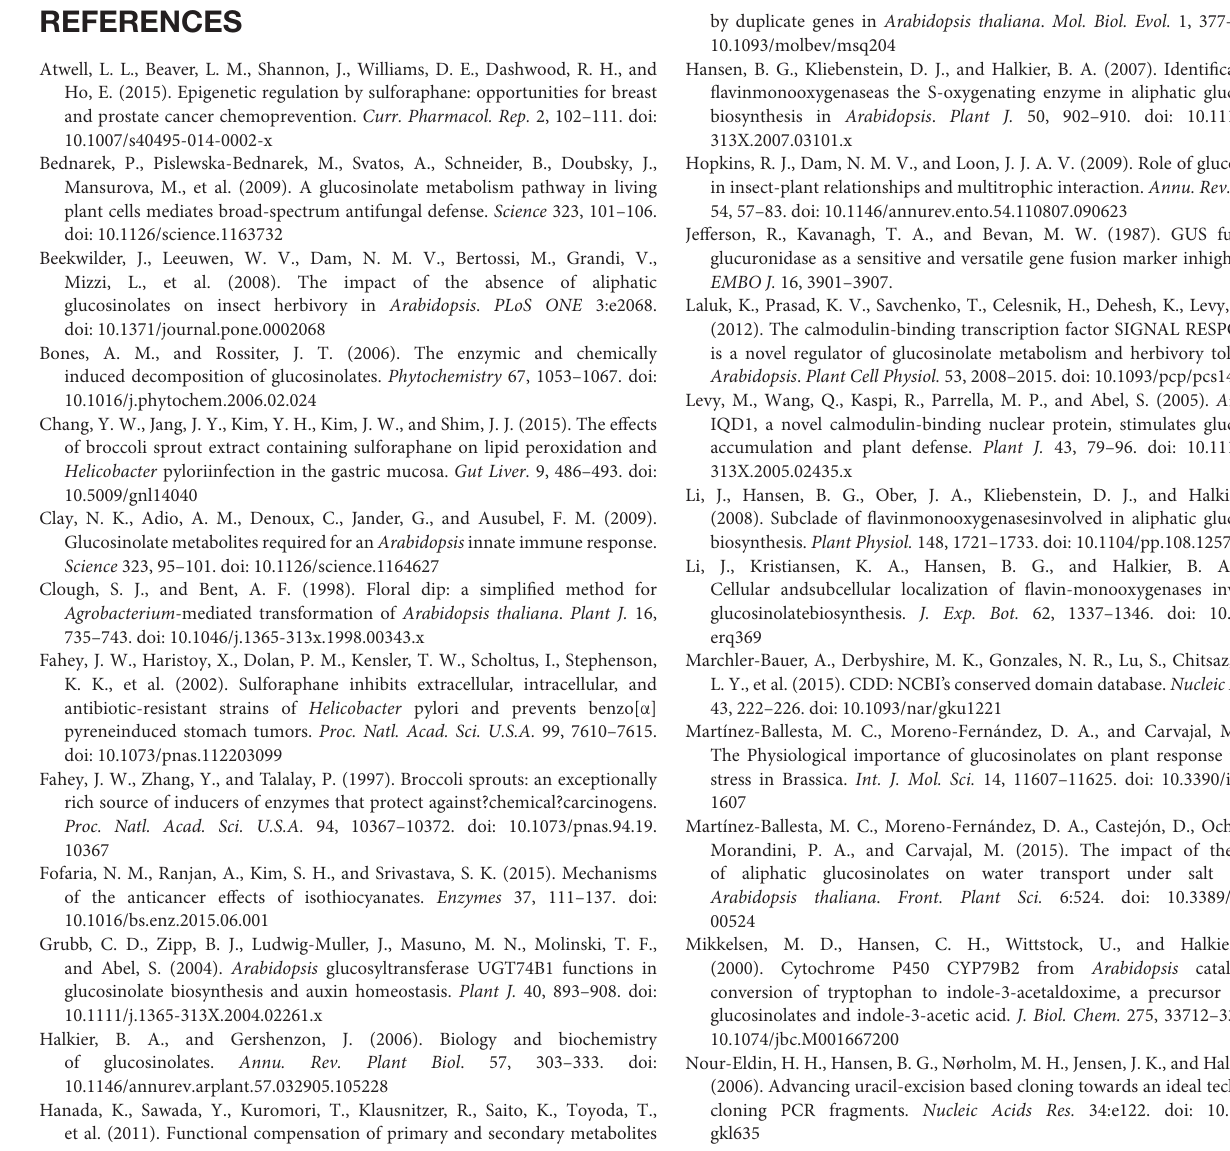
FIGURE S1 | Expression levels of FMO GS - OX 6 and FMO GS - OX 7 in the overexpression